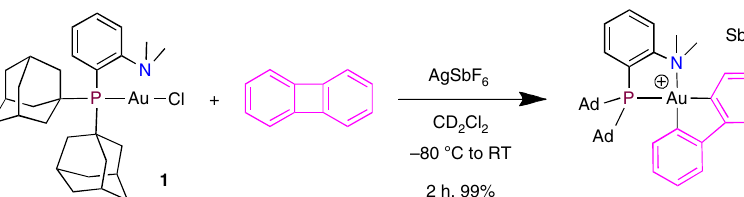
Fig. 3 Oxidative addition of biphenylene to gold. Reaction of biphenylene with complex 1 in the presence of AgSbF 6 ( Ad = 1-adamantyl)